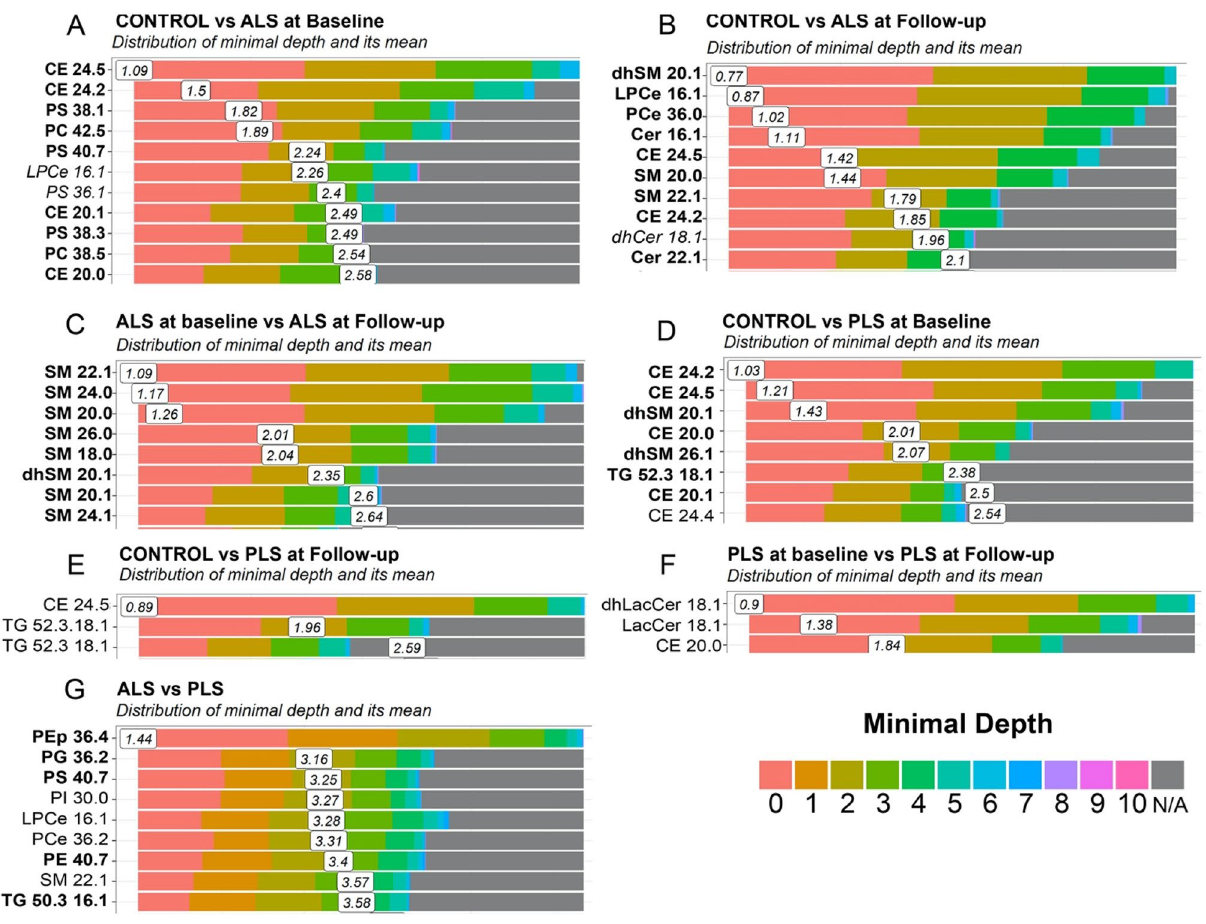
Figure 3. Random Forest plot representing the distribution of minimal depth and its mean for the indicated groups of samples. ( A ) Control versus ALS at baseline, ( B ) Control versus ALS at follow-up, ( C ) ALS at baseline versus ALS at follow-up, ( D ) Control versus PLS at baseline, ( E ) Control versus PLS at follow-up, ( F ) PLS at baseline PLS at follow-up, ( G ) Pooled ALS samples versus pooled PLS samples. Species also identified by oPLS-DA are shown in